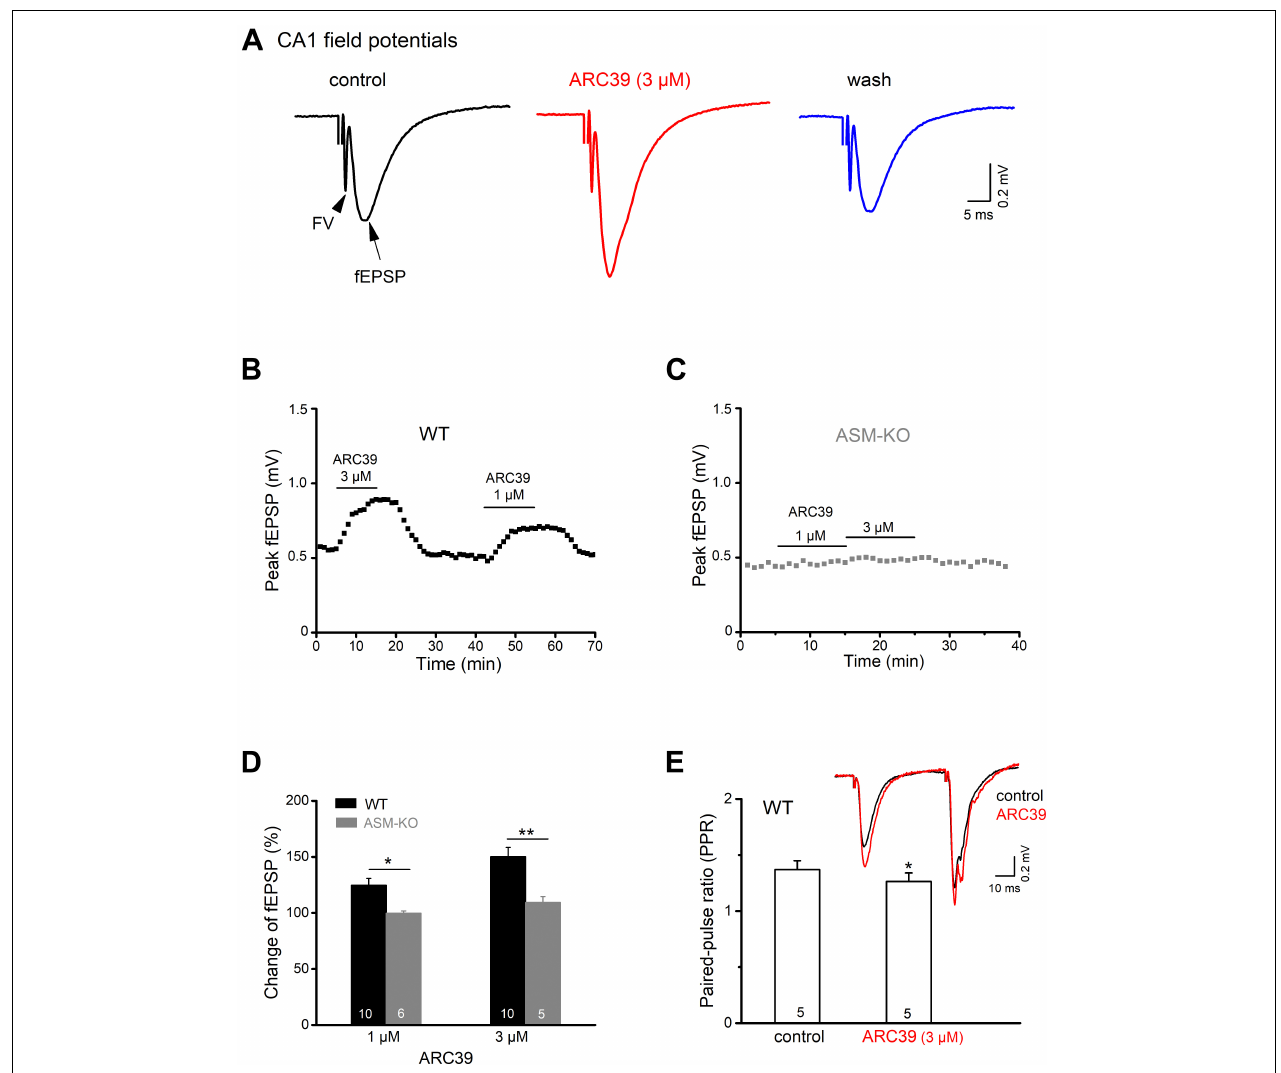
FIGURE 1 | ASM inhibitor ARC39 enhances excitatory transmission at the Schaffer-CA1 synapse. Field potentials were recorded from CA1 stratum radiatum in the presence of picrotoxin (100 µ M) to block GABA A receptor-mediated inhibition. (A) Representative voltage traces from wild type (wt) slice (stimulation intensity 50 µ A) before, during and after ARC39 (3 µ M) application. Stimulation artifact was truncated. Field potentials in response to electrical stimulation of Schaffer collaterals consisted of axonal firing (fiber volley, FV) and subsequent synaptic response (field EPSP). (B,C) Time courses of ARC39-induced changes in peak amplitude of CA1 fEPSPs in a wt slice [from recording shown in panel (A) ] and an ASM-KO slice. (D) Summary of dose-dependent effects of ARC39 on fEPSPs in wt and ASM-KO mice. (E) ARC39 reduced the paired-pulse ratio (PPR) of wt ventral CA1 fEPSP. Superimposed traces illustrate ARC39-induced effects on paired-pulse stimulation (40 µ A, separated by 50 ms). PPR was quantified by dividing peak amplitude of 2nd fEPSP by that of 1st one. Numbers in columns indicate sample size. * p < 0.05, ** p <